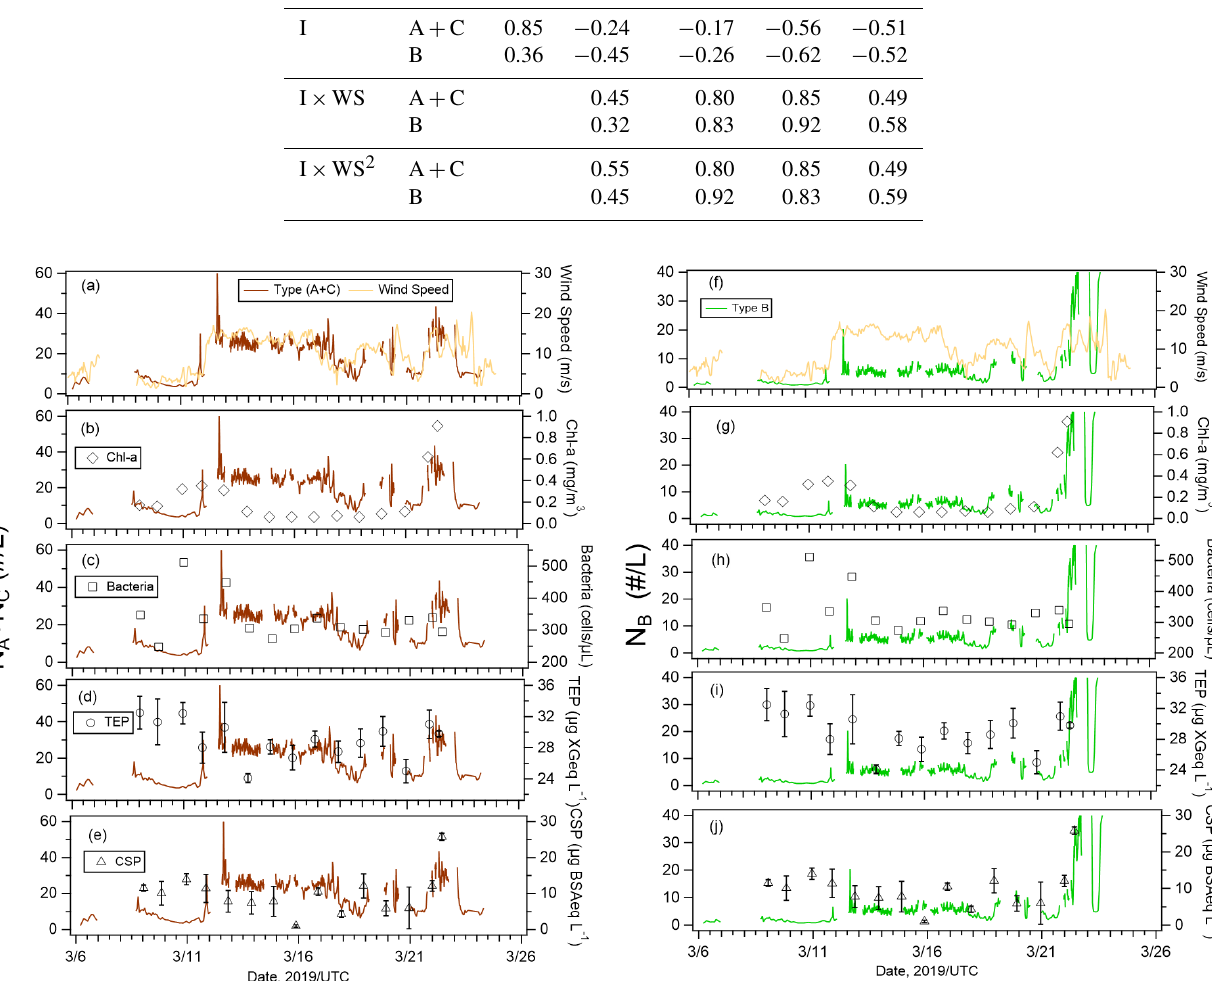
Table 3. Correlation coefficients between number concentrations of fluorescent aerosol particles (FAPs) in the atmosphere and wind speed (WS) and/or bioindicator (I) concentrations when oceanic air masses were dominant. FAPs vs.